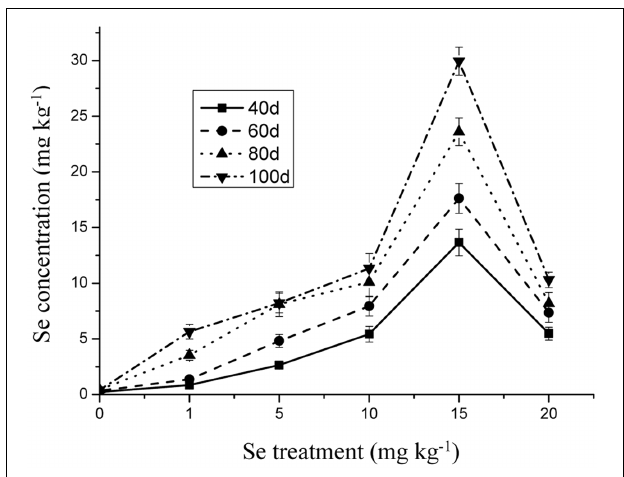
FIGURE 1 | Concentration of Se in shoots of oilseed rape treated with soil Se in different periods. Average concentrations (Dry biomass weight, DBW) provided with error bars representing the standard error. ( p ≤ 0.05).